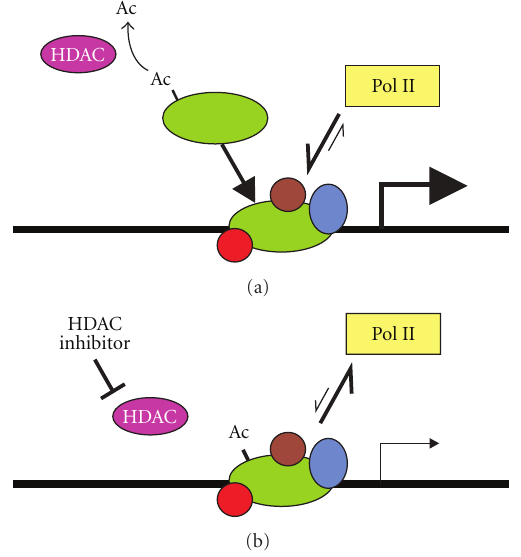
Figure 8: Proposed model for the role of HDACs in basal transcription from the MMTV promoter. (a) HDACs remove acetyl groups from proteins that are part of the reinitiation sca ff old. This may occur prior to binding to the template (as shown) or at the template. This deacetylation facilitates binding of RNA pol II and the initiation of transcription. When HDAC activity is inhibited through HDAC inhibitors, shown in (b) persistent acetylation of basal transcription machinery components does not destabilize the complex or prevent its assembly. However, the recruitment of RNA pol II is impaired, leading to a decrease in the rate of transcriptional